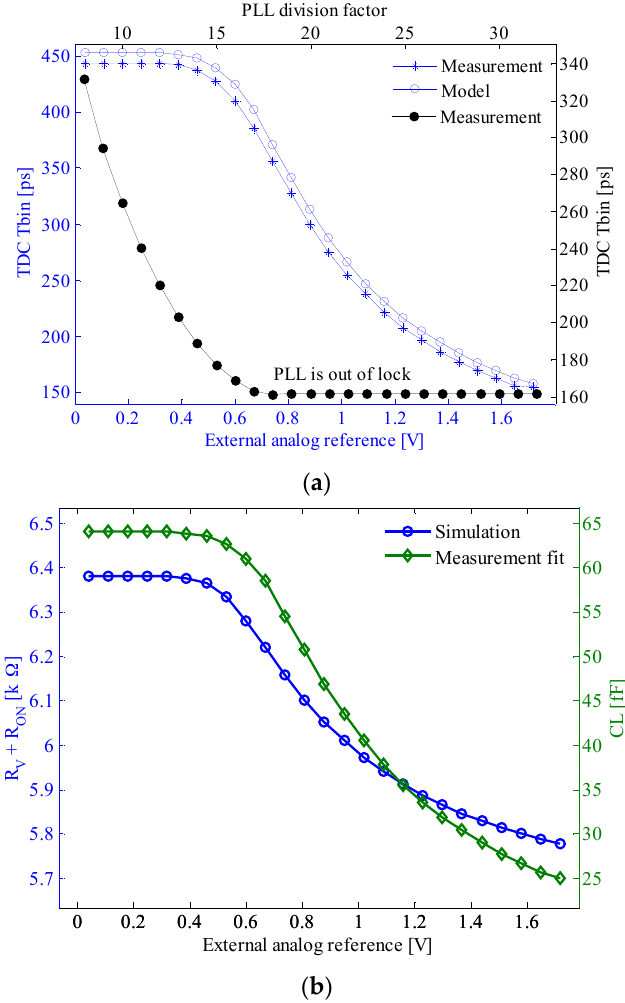
Figure 6. ( a ) TDC T bin dependence on the frequency control voltage which is either internal (dot marker; upper-right XY axes) or external (asterisk marker for measurement and circle marker for model; lower-left XY axes). ( b ) The equivalent resistance R V + R ON (circle marker; left Y-axis) and output capacitance C L (diamond marker; right